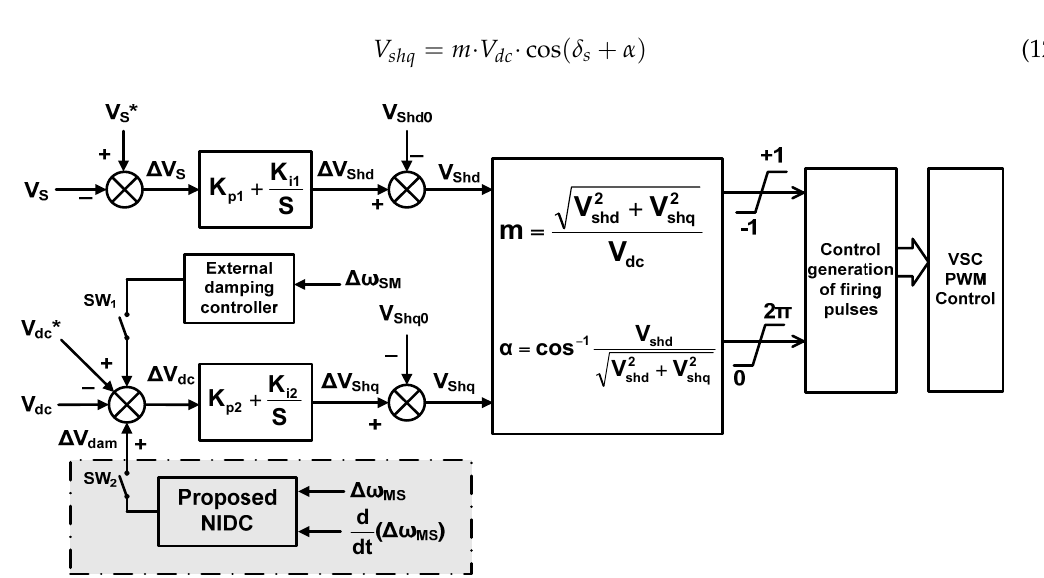
Figure 2. The control block of the STATCOM with damping controller.